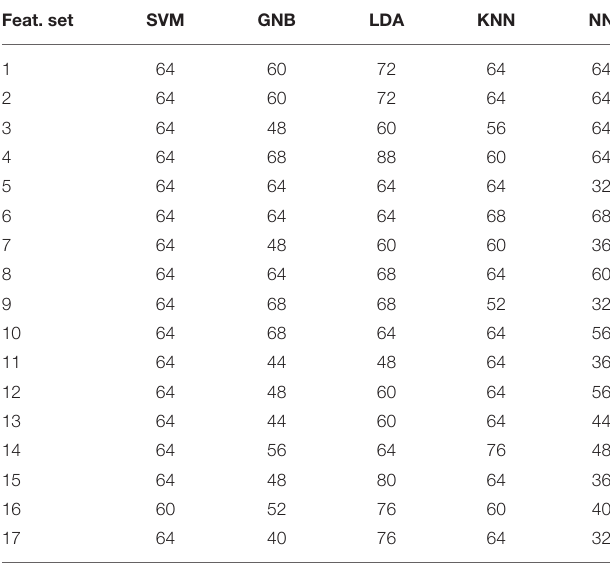
TABLE 2 | Performance of different models at different extracted features for speech (S) modality obtained from SP channel. Feat. set